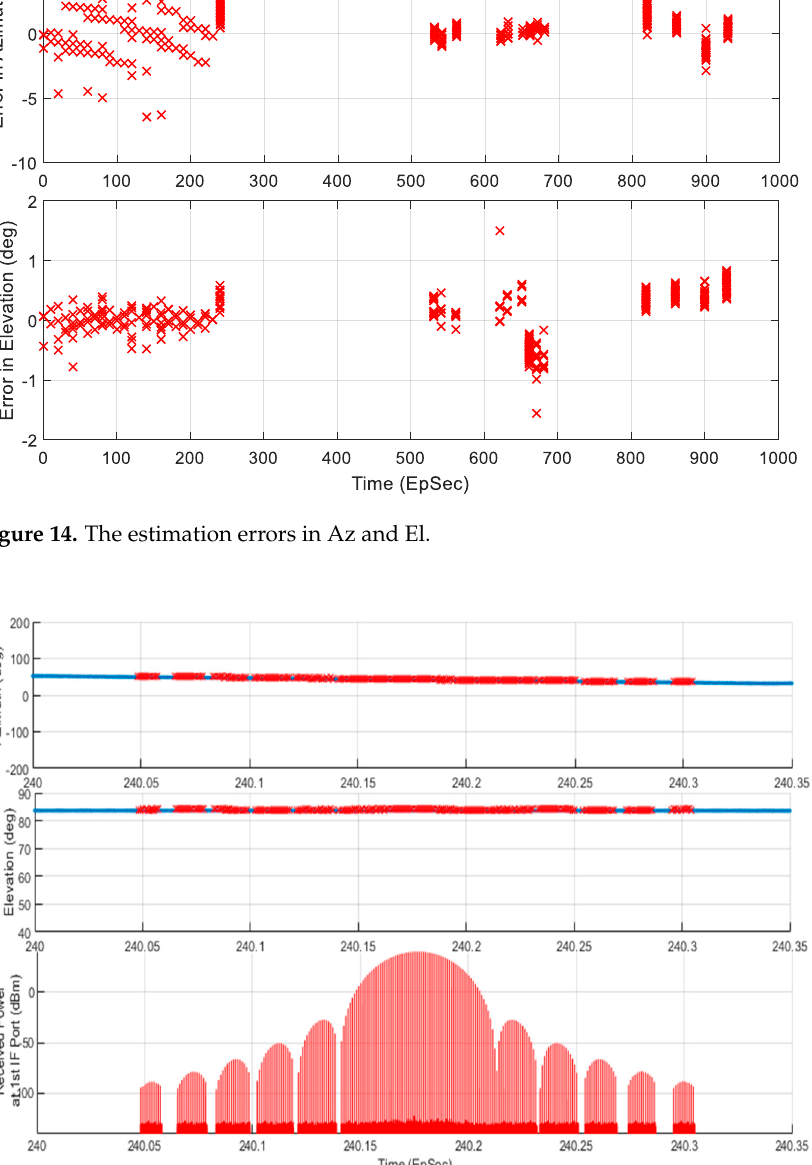
Figure 15. Zoom in plot of the last line of the TS1 in the bottom plot of Figure 13.